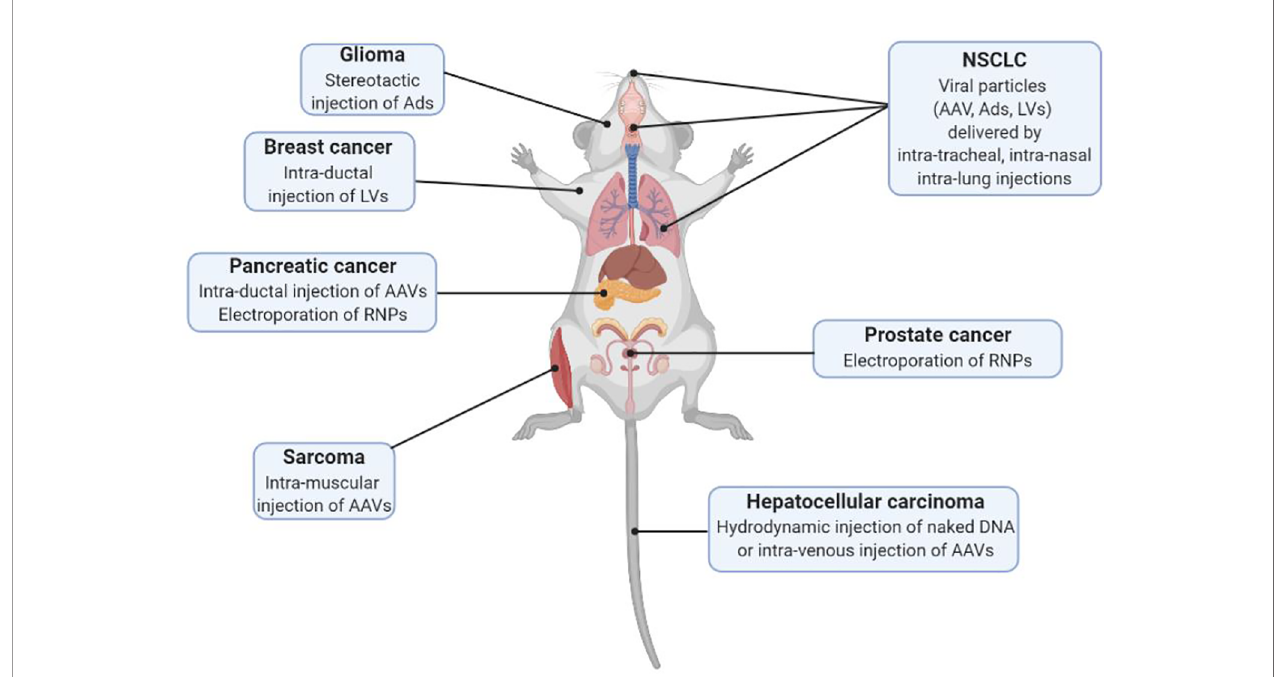
FIGURE 1 | Schematic representation of different delivery modalities of the CRISPR/Cas9 system in vivo for SEMM generation (AAV, Adeno Associated Virus; Ads, Adenoviruses; LVs, Lentiviruses; RNPs,